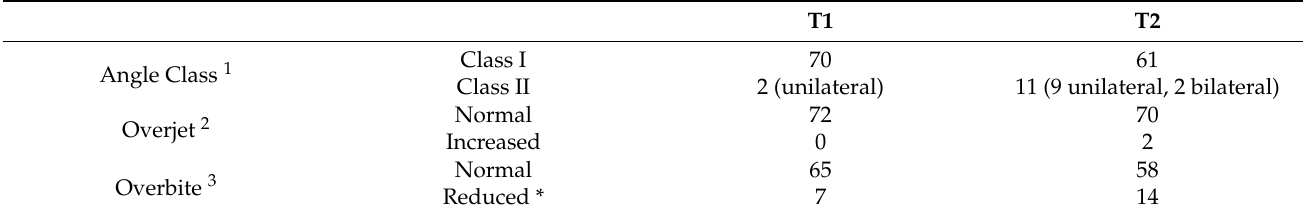
Table 2. Occlusal characteristics of the studied